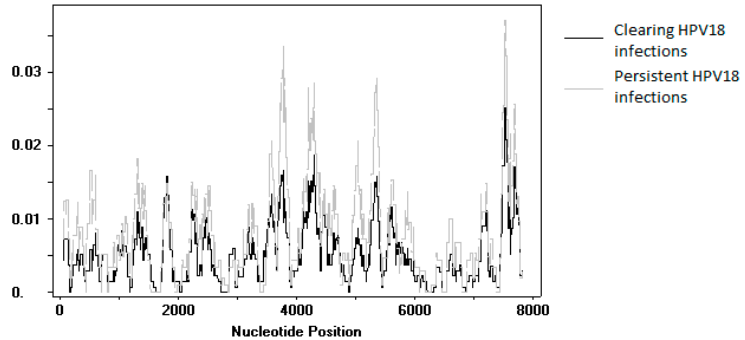
Figure 4. Plot of nucleotide diversity (pi) of human papillomavirus (HPV) 18 sequences obtained in this study. The black line shows data from clearing infections ( n = 25), while the grey line shows data from persistent infections ( n = 20).